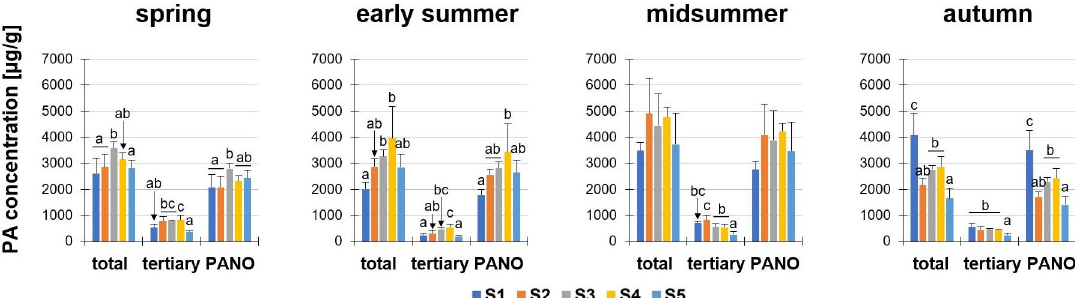
Figure 2. PA concentration µ g/g in dry matter (dm) of Senecio vulgaris L. plants depending on the developmental stage (S1 to S5) and season. Data are values for (i) total concentration of PAs (“total”; tertiary PAs and PA- N -oxides), (ii) concentration of tertiary PAs (“tertiary”; Re, Sp, Sv, Sc, Sk) and (iii) concentration of PA- N -oxides (“PANO”; ReN, SpN, SvN, ScN). Results are means ± SD of five different determinations (distinct sub-trials, see Supplemental Figures S2 and S3). Different letters identify significant differences ( p < 0.05) between developmental stages (ANOVA, Tukey’s honest significance difference).